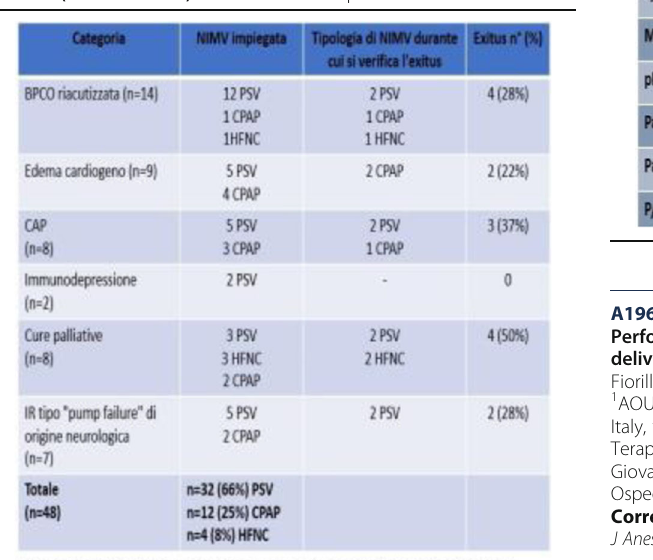
Table 2 (abstract A195). See text for description